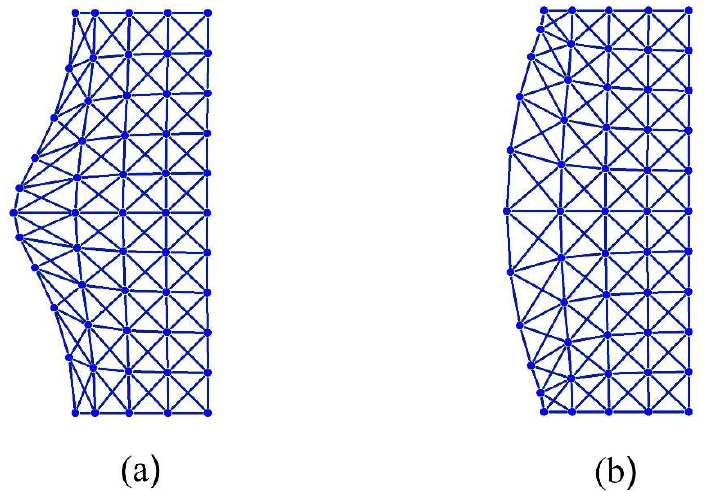
(cid:2869) 𝜋 , 𝑚 = 0 → (cid:2873)